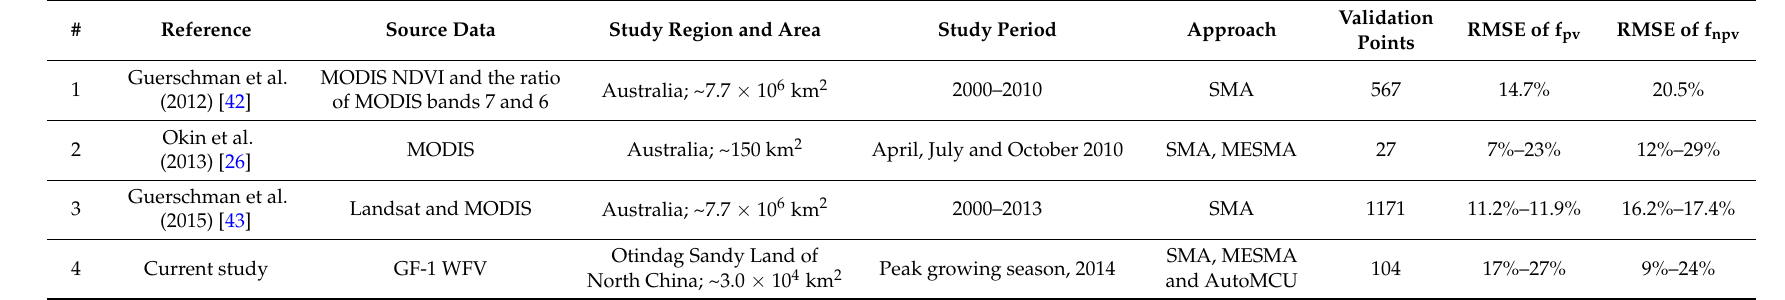
Table 4. Comparison of multispectral remote sensing-based f pv and f npv